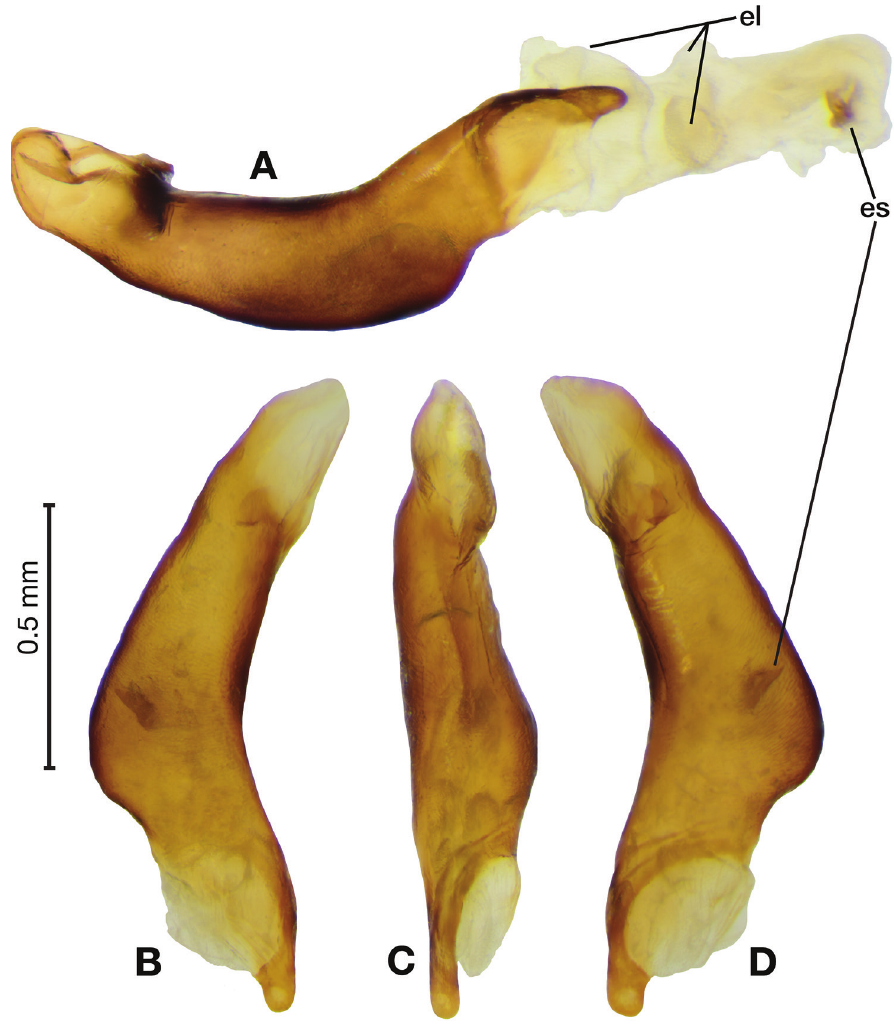
Figure 5. Digital images of male genitalia of Amphimenes absensacidus sp. n.. A right lateral aspect, endophallus everted B right lateral aspect C ventral aspect D left lateral aspect. Legend: el endophallic lobes; es endophallic